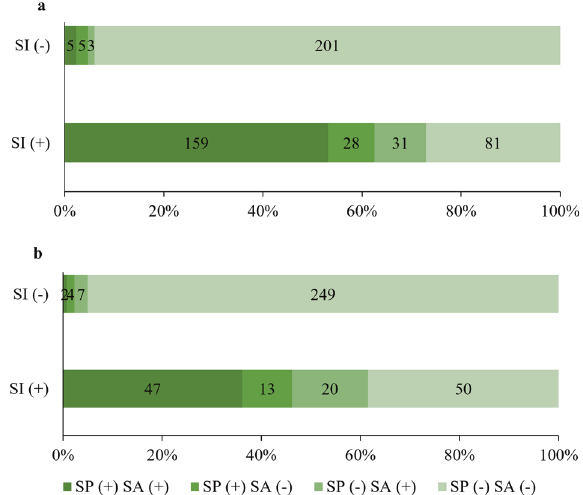
Fig. 1 Distribution of suicide plan and suicide attempt in patients with and without suicidal ideation. Note: Numbers in bar graphs indicate patient counts. a shows counts of suicide plans (SP) and suicide attempts (SA) in BD patients by presence of SI. b shows SP and SA in SCZ by presence of SI. SI increases the risk for SP and SA in both disorders ( p < 0.001).